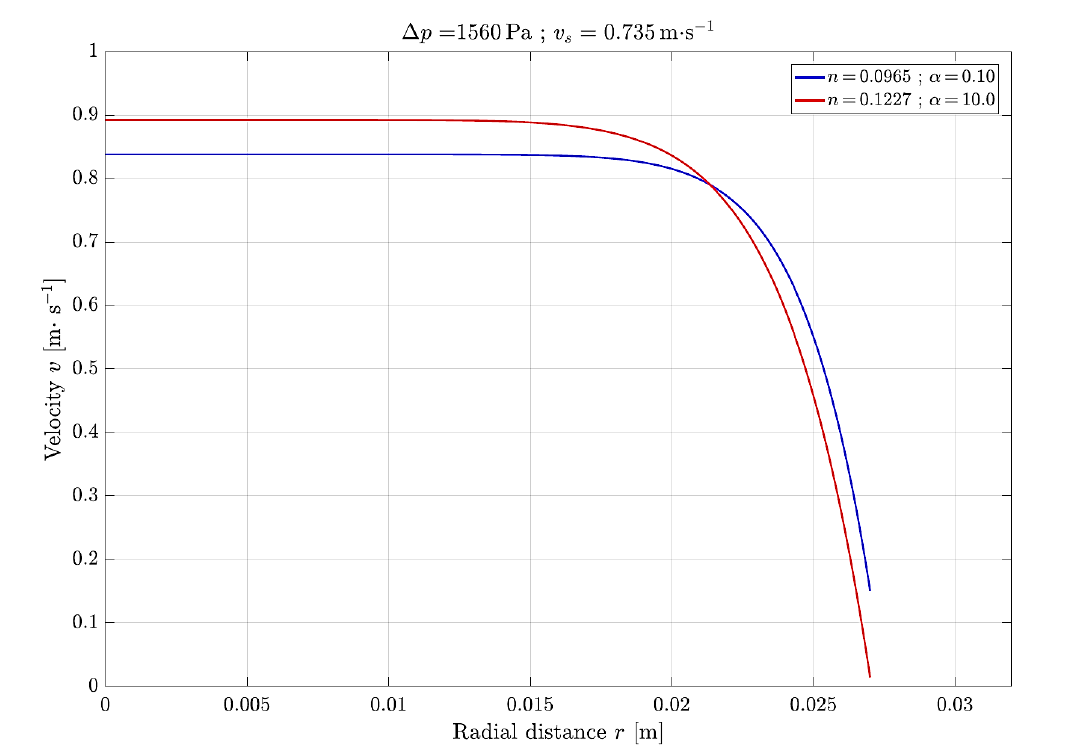
Fig. 3. Turbulent velocity profiles for a constant pressure drop and a constant mean velocity.